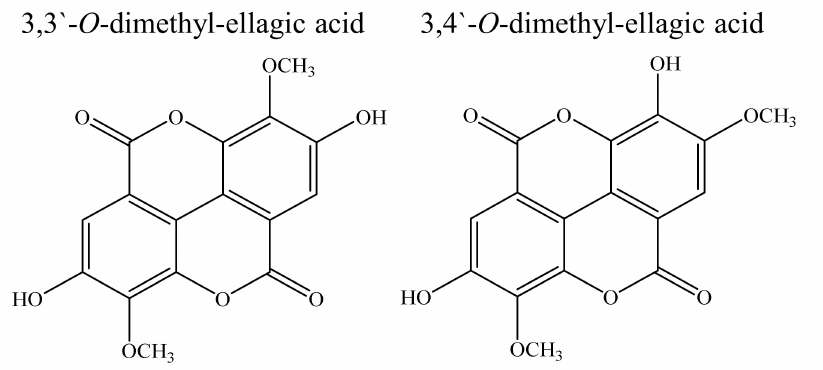
Figure 4. Chemical structure of potential isomers of 1 (3,3 (cid:48) - O -dimethyl-ellagic acid and 3,4 (cid:48) - O - dimethyl-ellagic acid).